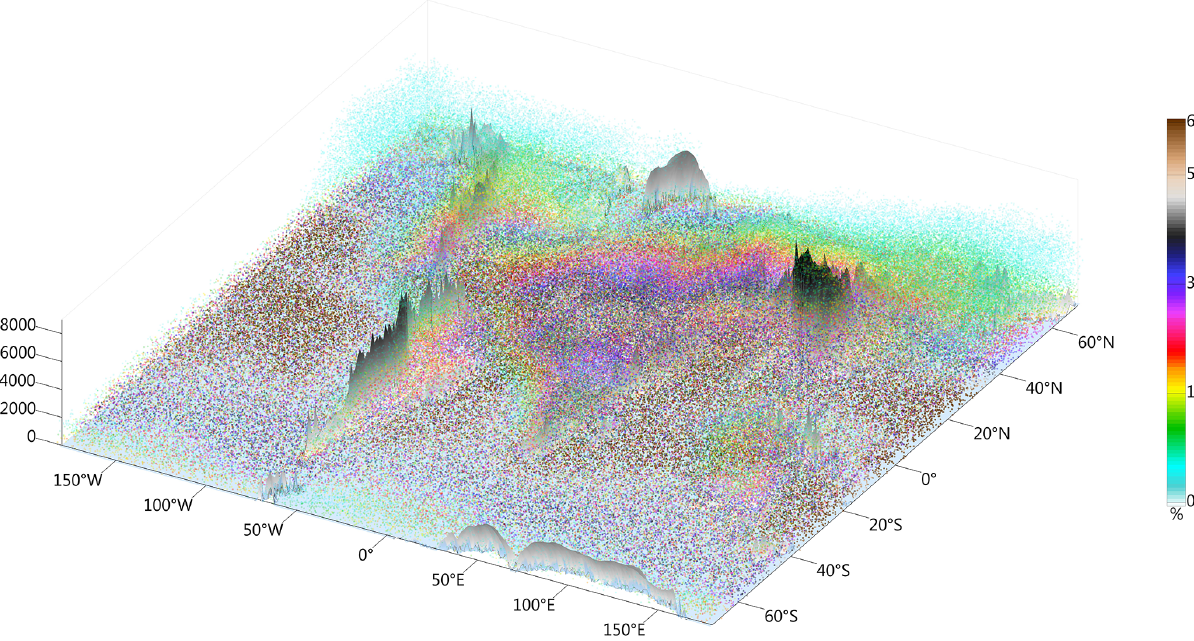
the 3D distribution of FoO for both clean-type aerosols